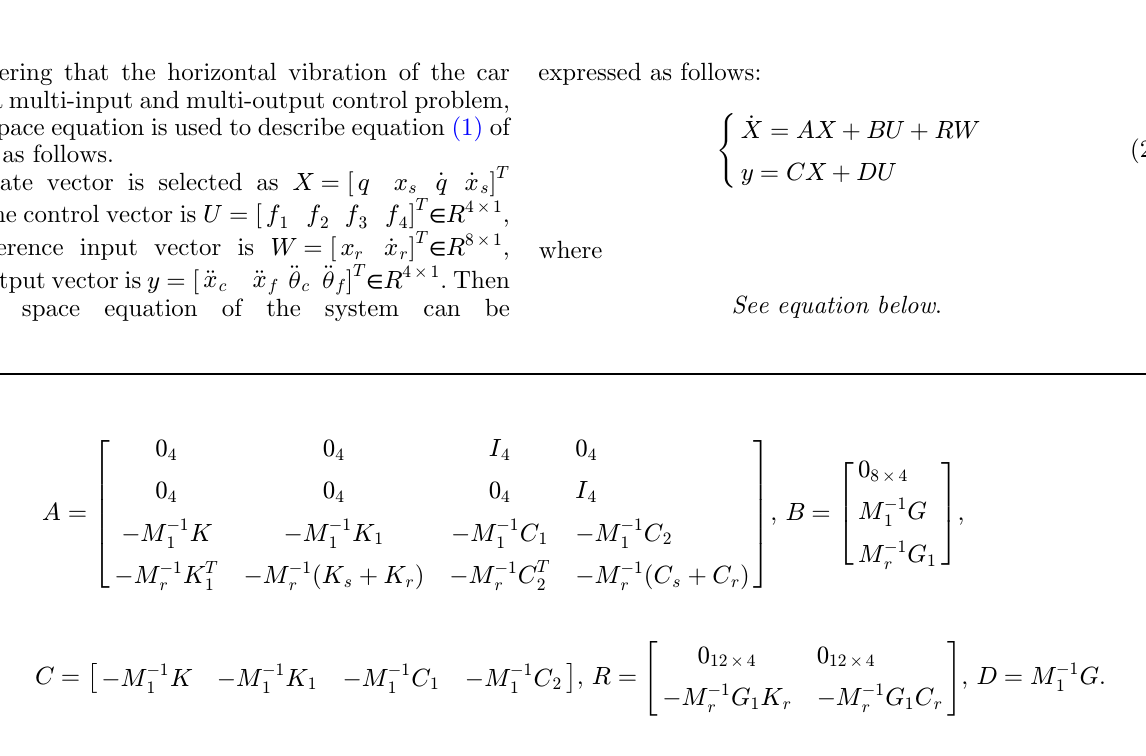
Fig. 3. Horizontal vibration model of the high-speed elevator car system with active